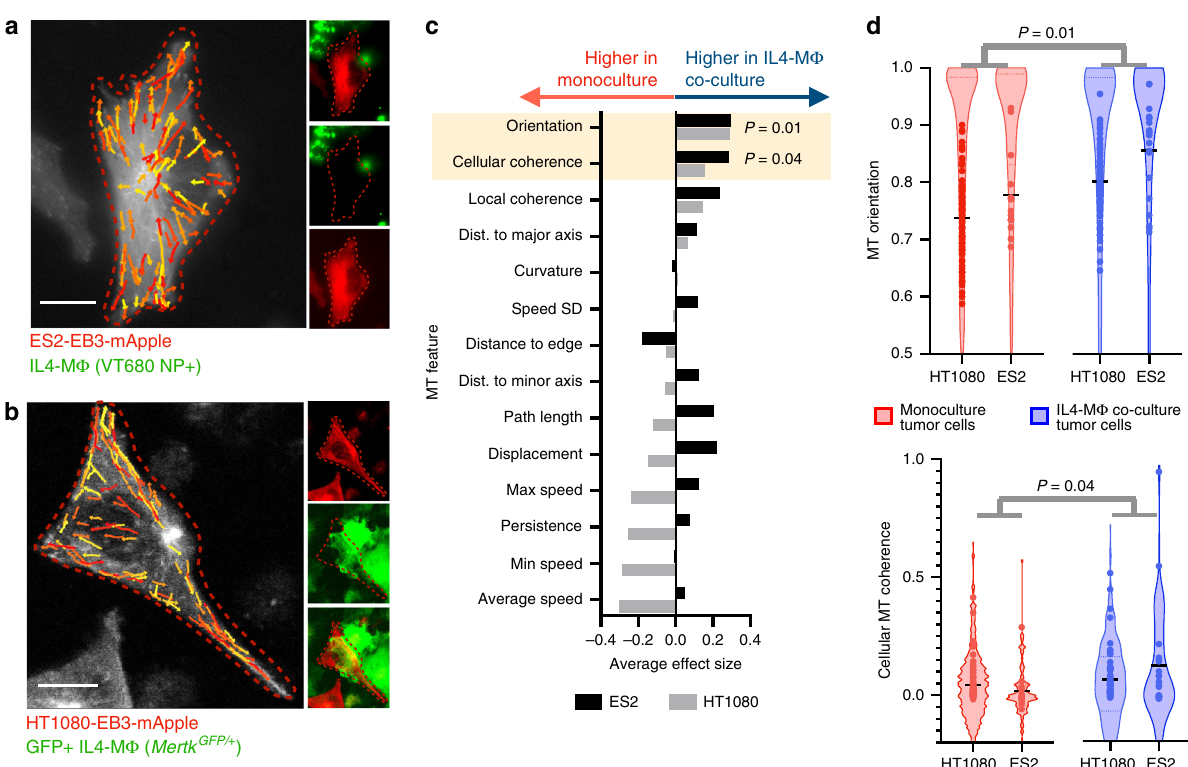
Fig. 4 IL4-polarized M Φ promote coherent MT alignment in neighboring tumor cells. a , b Representative fl uorescence microscopy after 24 h of IL4-M Φ co-culture with EB3 tracks randomly pseudo-colored for visualization (scale bar = 10 μ m). c Corresponding to a , b , the effect size for imaged MT features was compared between monoculture and 24 h M Φ co-culture (average of Cohen ’ s D effect size between batches). d From c , track distributions for the top two increased MT features, altered in both cell lines with co-culture, are shown with cell averages overlaid as individual data points (bar denotes median). All p values were computed using a two-tailed permutation test with BH correction. For HT1080 cells, n = 22,371 tracks across n = 164 total cells were analyzed, and for ES2 cells n = 1424 tracks across n = 33 total cells were analyzed. Source data are provided as a source data fi